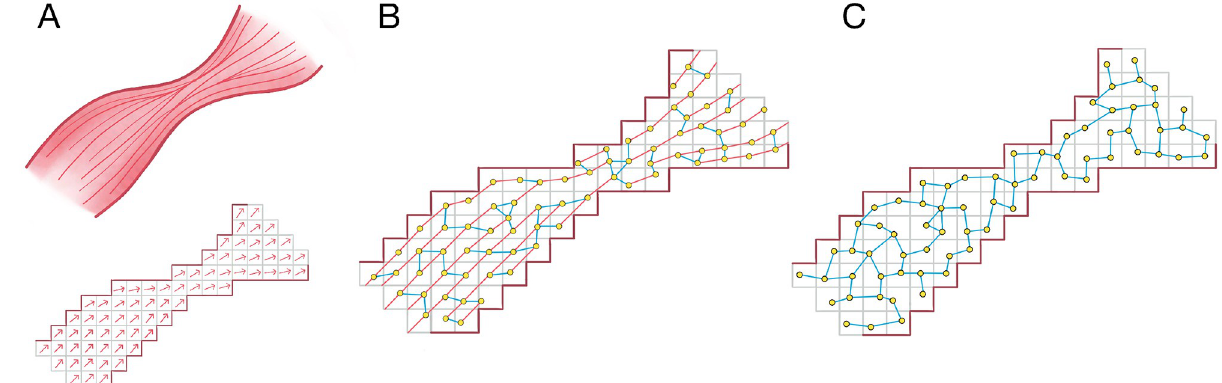
Fig 2. A schematic showing the construction of spatial networks from atrial imaging data. (A) An image based model of the atria is derived from atrial imaging. The model, represented by a mesh of voxels, is coupled with vectors representing the underlying fibre orientation at each point. (B) In the fibre model, a spatial network is generated where nodes (yellow points) are connected with probability 1 along fibre tracts (pink edges), and low probability across fibre tracts (blue edges). (C) In the fibre-less null model, the probability of forming an edge is not biased by the underlying fibre